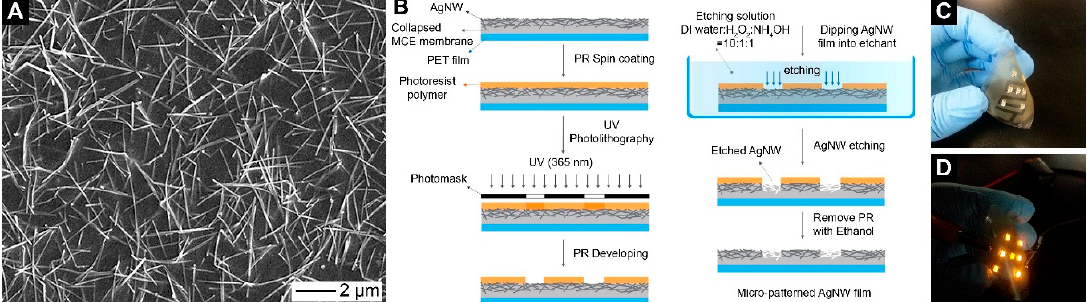
Figure 3. ( A ) Transparent Ag nanowire film supported by a collapsed mixed cellulose ester membrane. ( B ) Scheme of the photolithographic process used to pattern the Ag nanowire film. ( C , D ) Photographs of LED chips integrated on Ag nanowire electrodes with light off ( C ) and on ( D ), demonstrating the transparency, flexibility and conductivity of the nano-network films. Reprinted (adapted) with permission from [39]. Copyright (2015) Elsevier B.V.